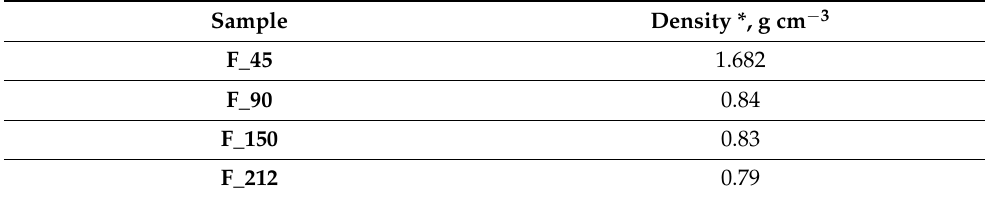
Table 6. Real density measurement CS data.